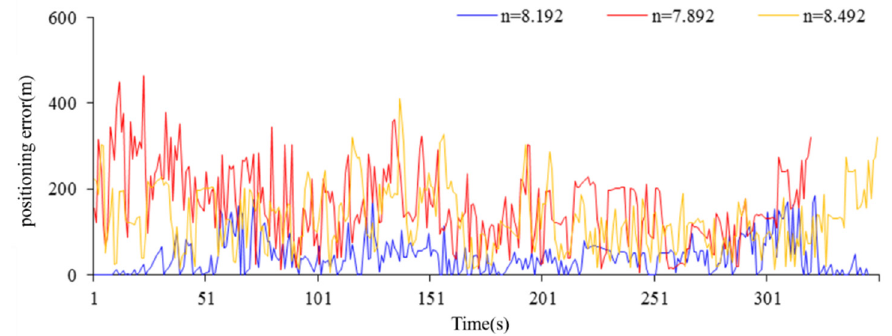
Figure 16. Different path loss coefficients of fusion positioning error.